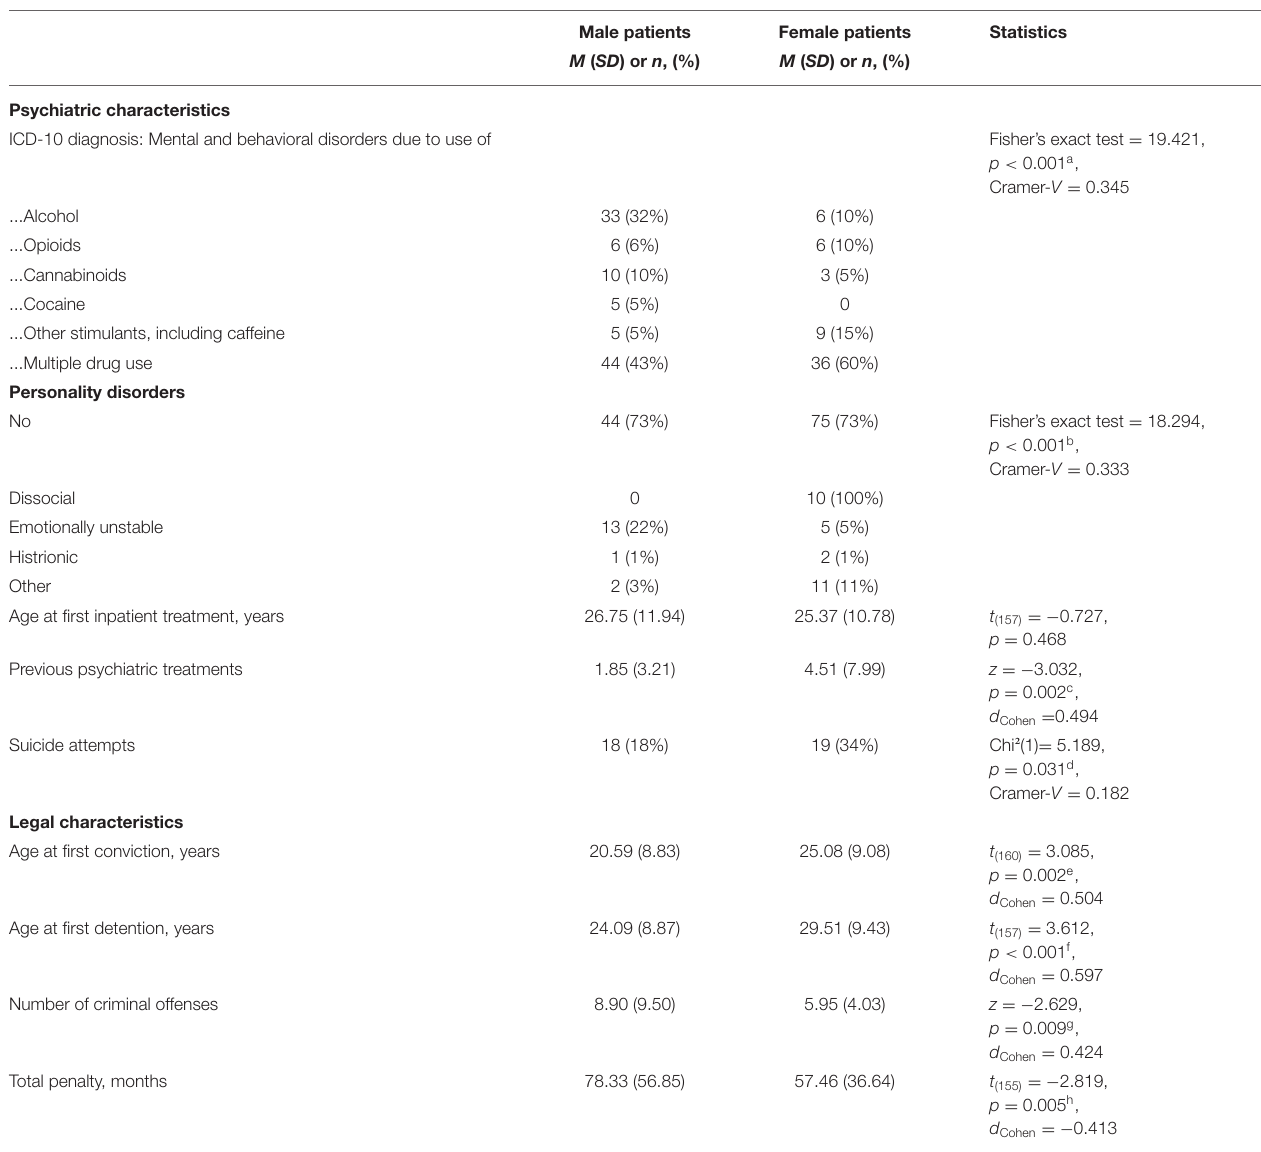
TABLE 2 | Differences in psychiatric and legal characteristics between male ( n = 115) and female ( n = 61) forensic psychiatric inpatients with substance use disorders. Male